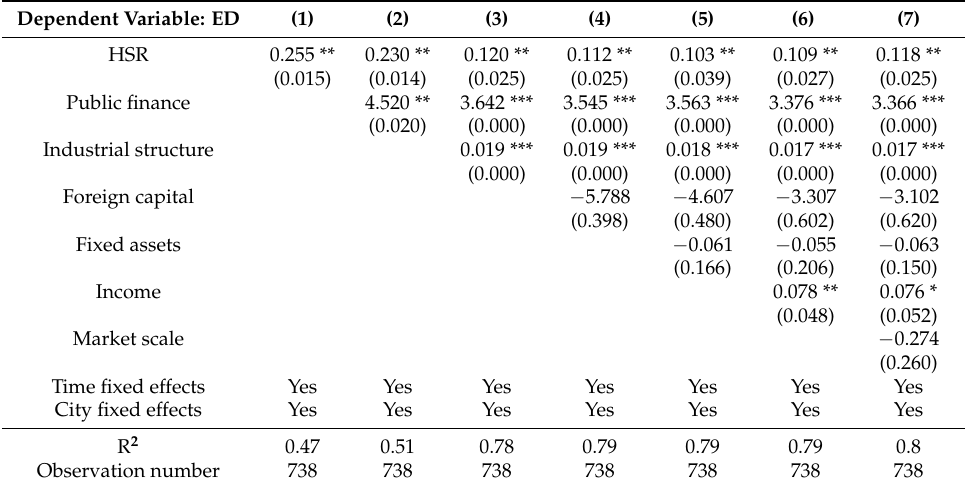
Table 2. The impact of HSR on regional economic development.